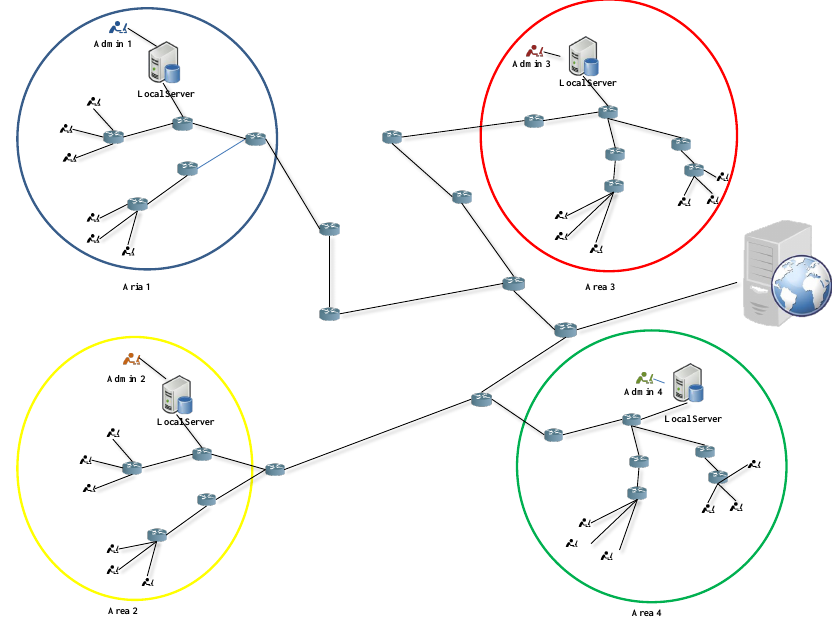
Figure 2. Example of targeted